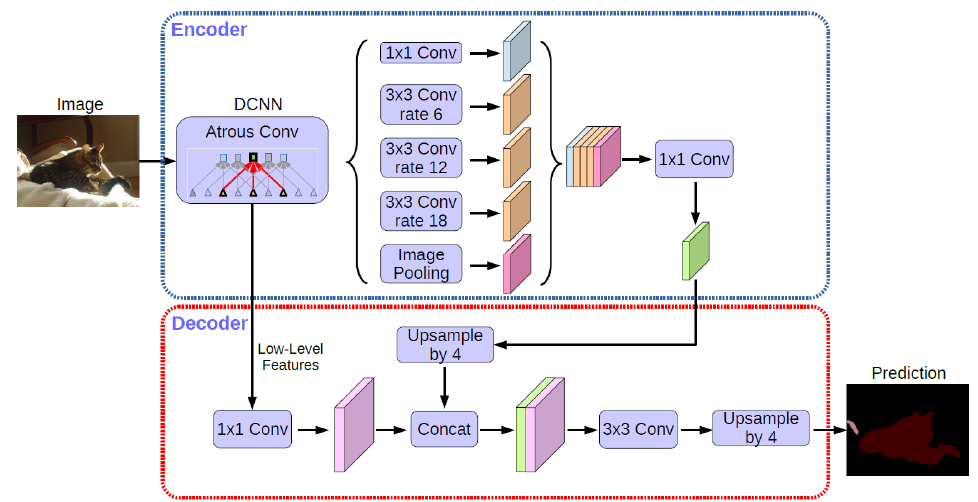
Figure 3. DeepLab V3+ network structure .